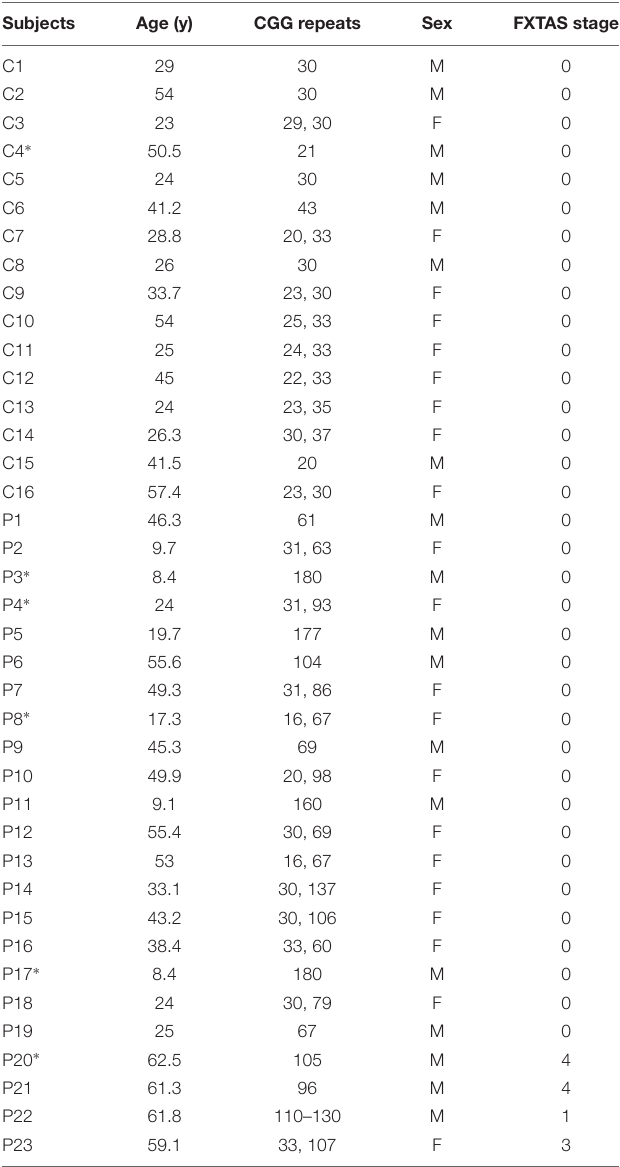
TABLE 1 | Demographics and clinical characteristics of plasma donors included in this